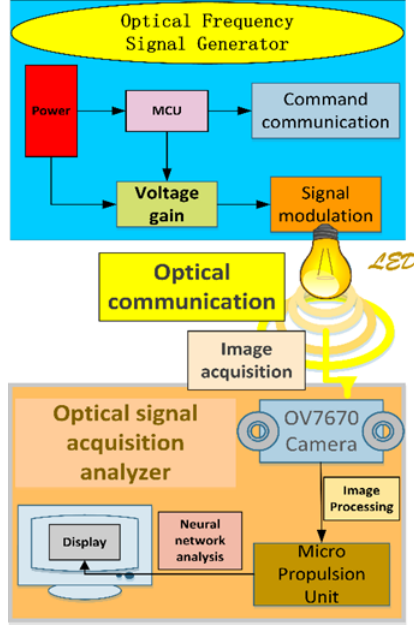
Figure 2 . Visible light flashing stripe images Among them, the data frame is composed of 10 codes, and the start bit and end bit are composed of two letters "A" and "B" mapped from the 800HZ and 1600HZ frequency images. As shown in Figure 3 When the receiving end detects the continuous appearance of "A" and "B", the data bits in the middle will be analysed. The data bit consists of "0" and "1" represented by 200HZ and 400HZ, including the room number used to represent the space and the location number of the area. If an optical frequency signal generator is located in position 2 of Room 1, it will be programmed to blink periodically at the frequency corresponding to the sequence "AB-01-0010-AB", and the other optical frequency signal generator is located in position 3 of Room 2. Then it will be programmed to blink periodically according to the optical frequency corresponding to the sequence "AB-10-0011-AB", each data bit lasts for 5ms, and the total time to successfully encode a complete string of addresses is about 50ms. The address coding method based on the above description can be applied to distinguish and identify 64 location targets, fully meeting the positioning requirements in general indoor scenes. By increasing the coding bits of room number, it can also be applied to shopping malls, hospitals and other larger